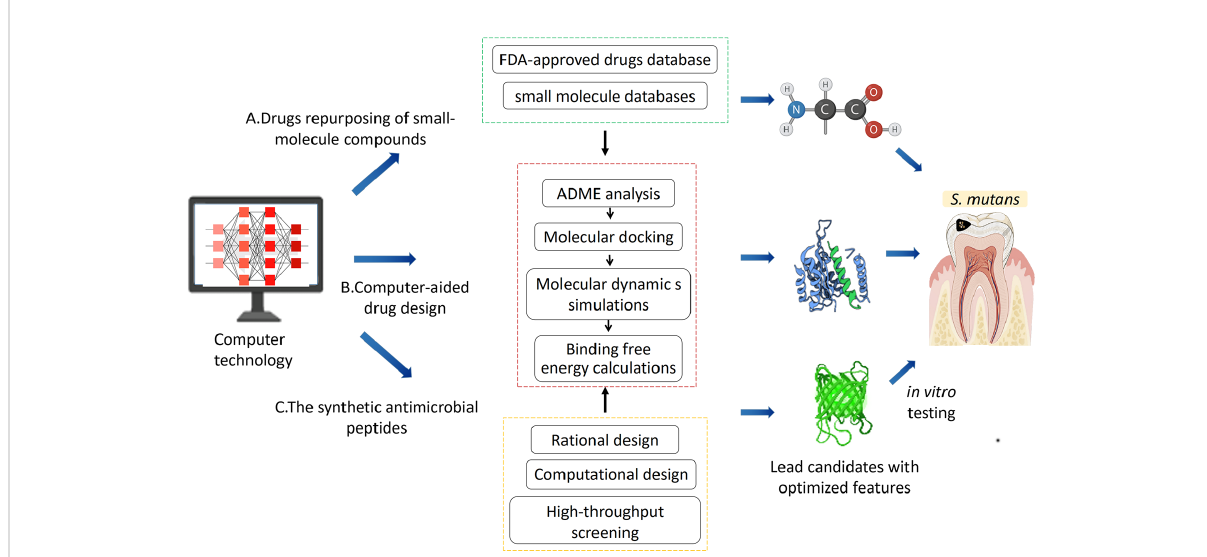
FIGURE 1 The computer technologies employed to discover novel antimicrobial agents including: (A) drug repurposing of small-molecule compounds; (B) computer-aided drug design; (C) the synthetic antimicrobial peptides. Then in vitro testing targeting the S.mutans was conducted to select the lead candidates with optimal